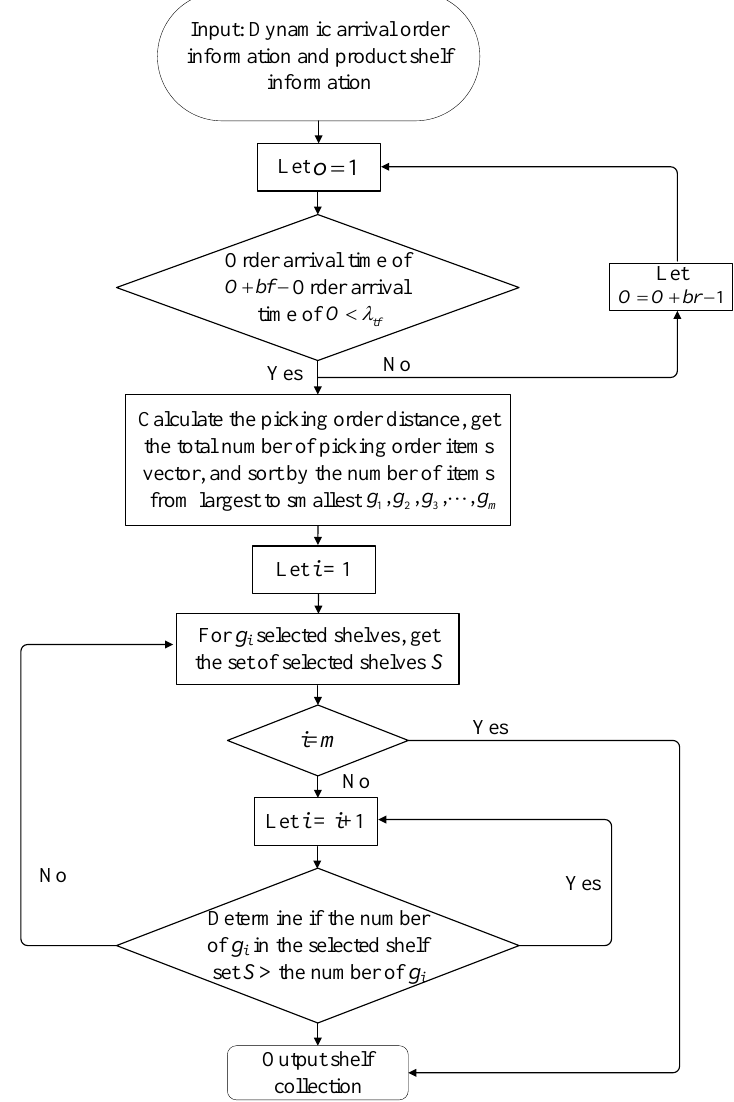
Figure 2. Hybrid time window algorithm flow.